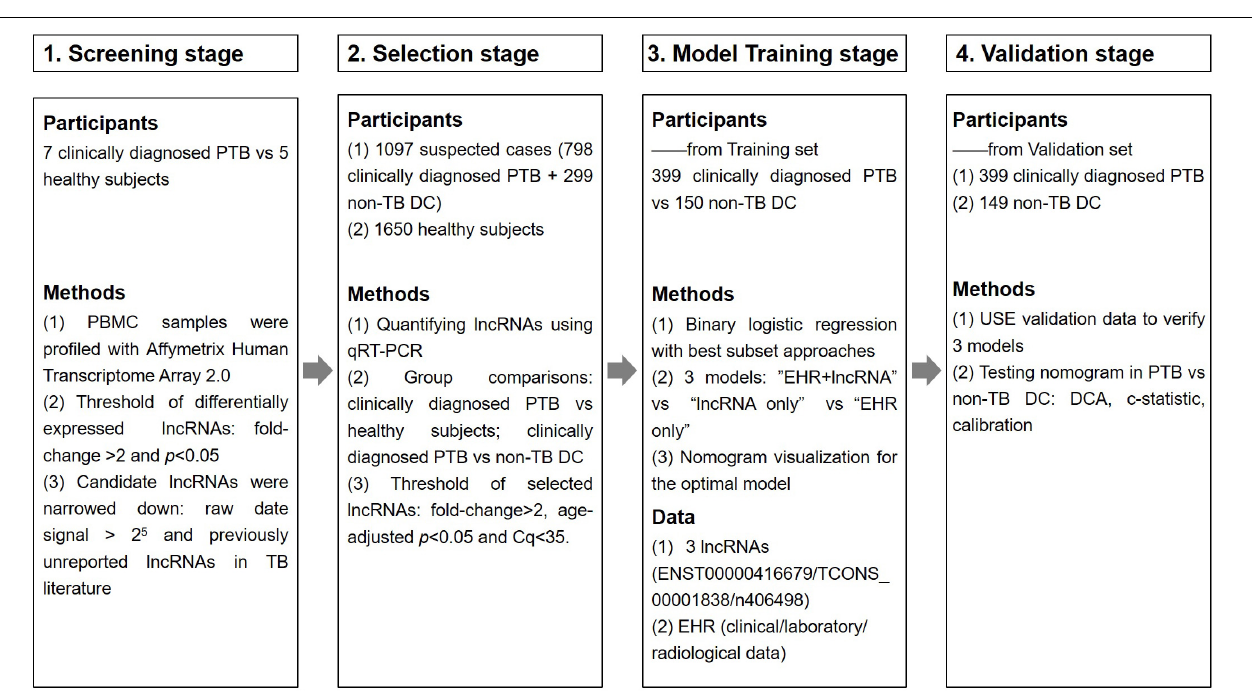
FIGURE 1 | Overview of the strategy for investigating lncRNAs and prediction models for clinically diagnosed PTB patients.